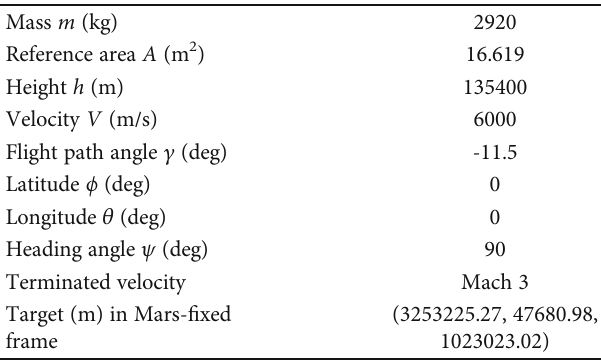
Table 8: Initial conditions, physical characteristics [26], and target on